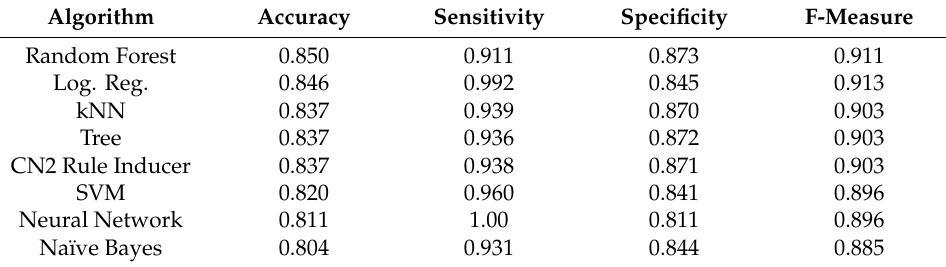
Table 4. Data transformation (equal frequency), feature selection